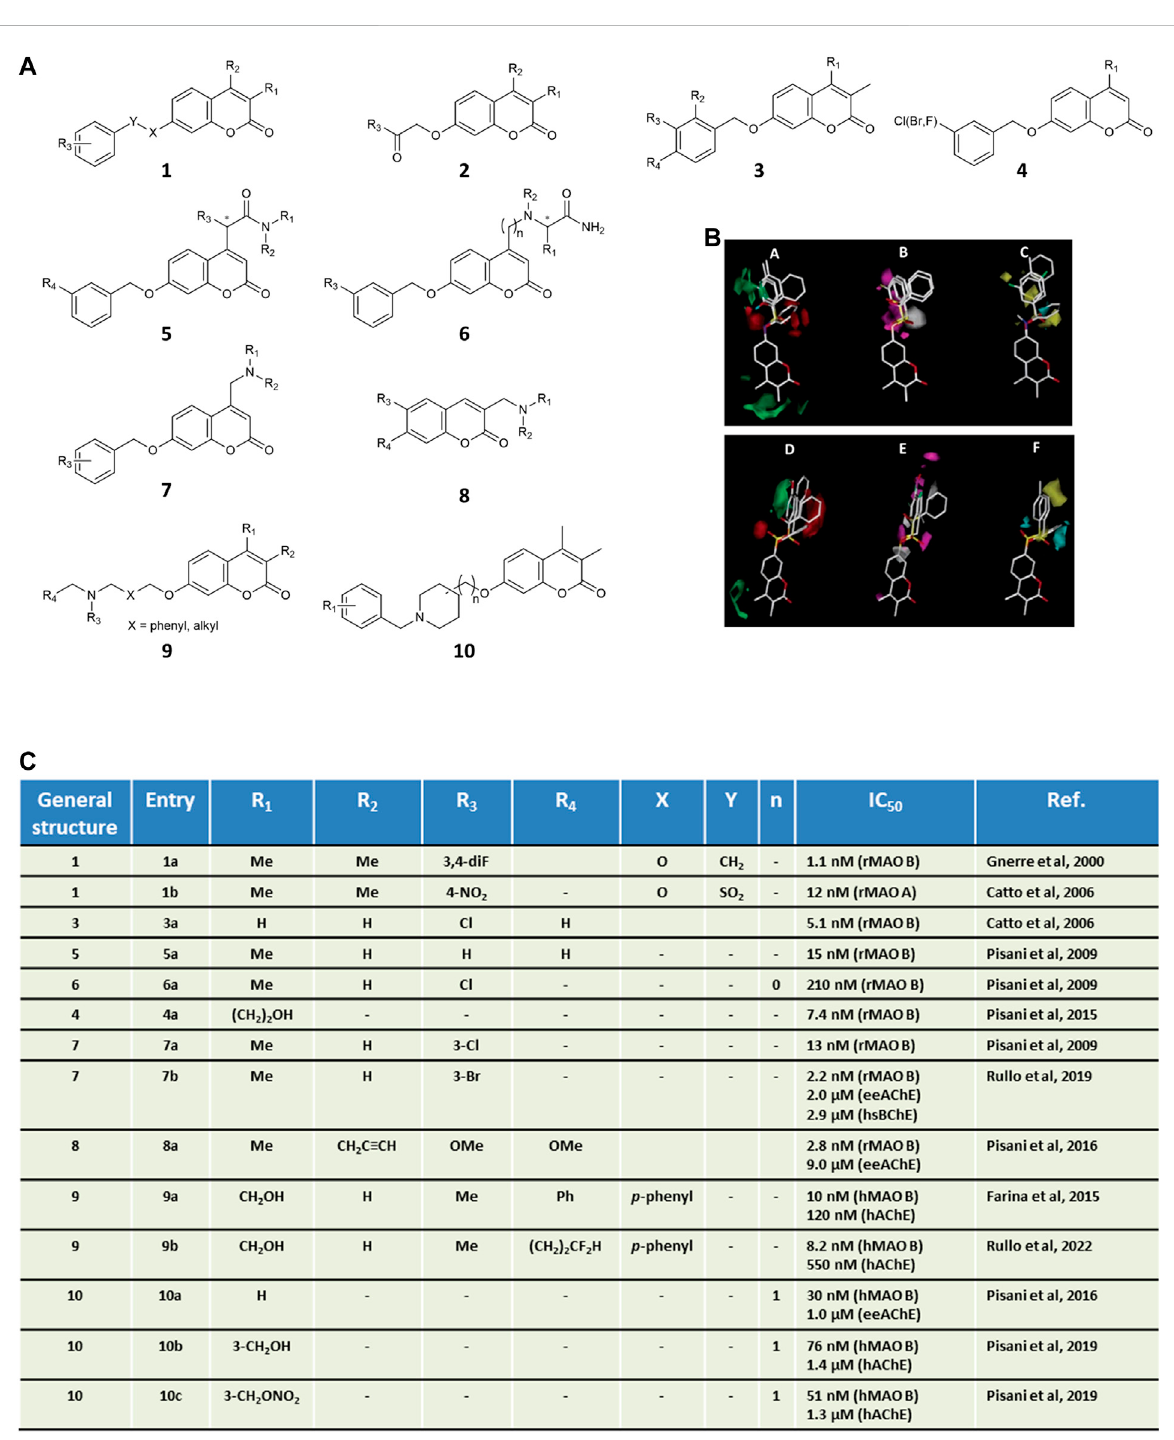
FIGURE 1 Panel (A) general structures of coumarin-based MAO inhibitors and MTDLs. Panel (B) CoMFA isocontour maps for MAO B (A – C) and MAO A (D – F) af fi nity of coumarin derivatives of general structure 1. In steric maps A and D, green and red regions show allowed and forbidden regions, respectively. Electronic density areas (B,E) are depicted as favorable (magenta) and unfavorable (grey), respectively. Lipophilic interactions (C,F) are reported as favorable (yellow) and unfavorable (cyan), respectively. CoMFA images were adapted with permission from Ref. (Catto et al., 2006). Copyright 2006, American Chemical Society. Panel (C) in vitro inhibitory data for the selected